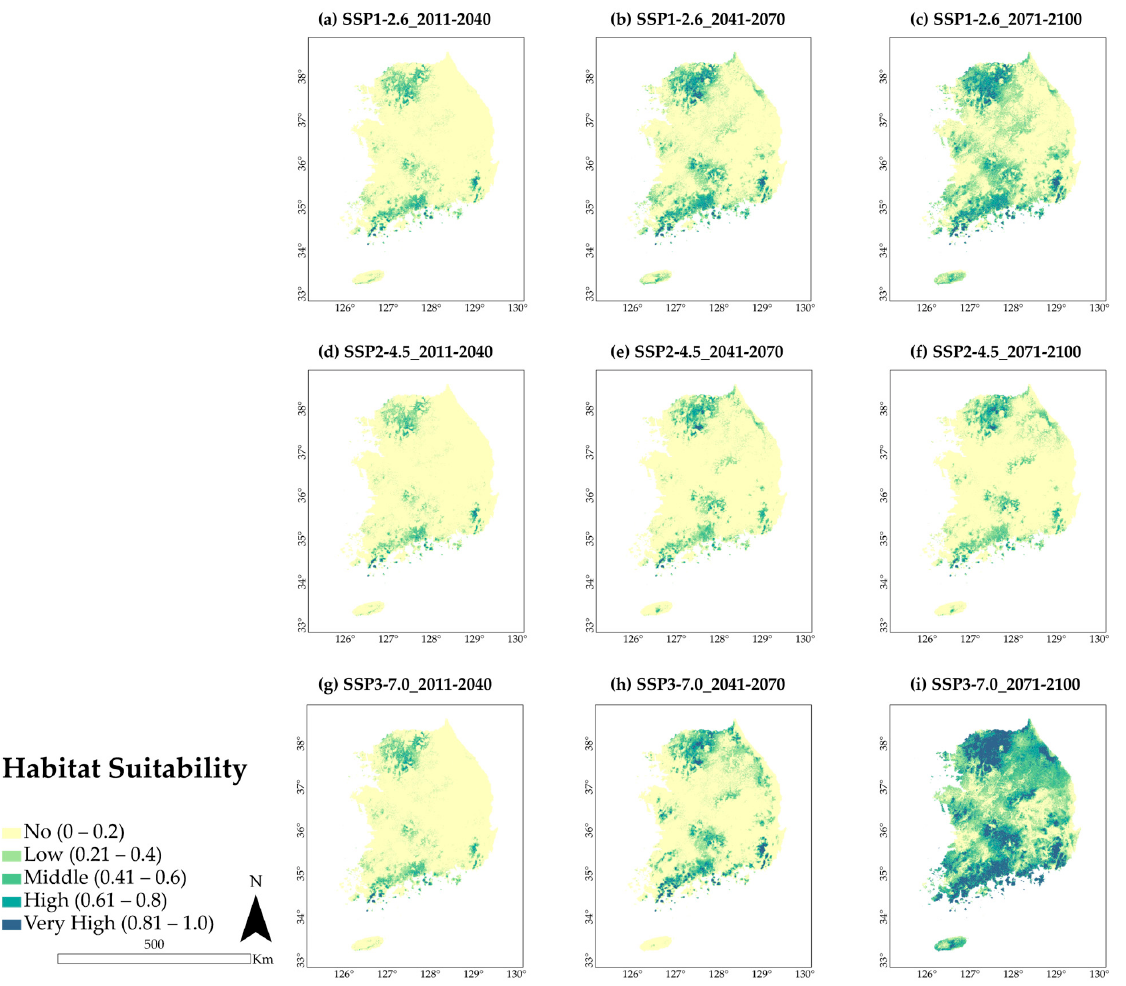
Figure A6. The potential distribution of Q. acuta under future climate conditions. ( a – c ) indicate the potential distribution at three periods under SSP1-2.6, respectively; ( d – f ) indicate the potential distribution at three periods under SSP2-4.5, respectively; ( g – i ) indicate the potential distribution at three periods under SSP3-7.0, respectively.